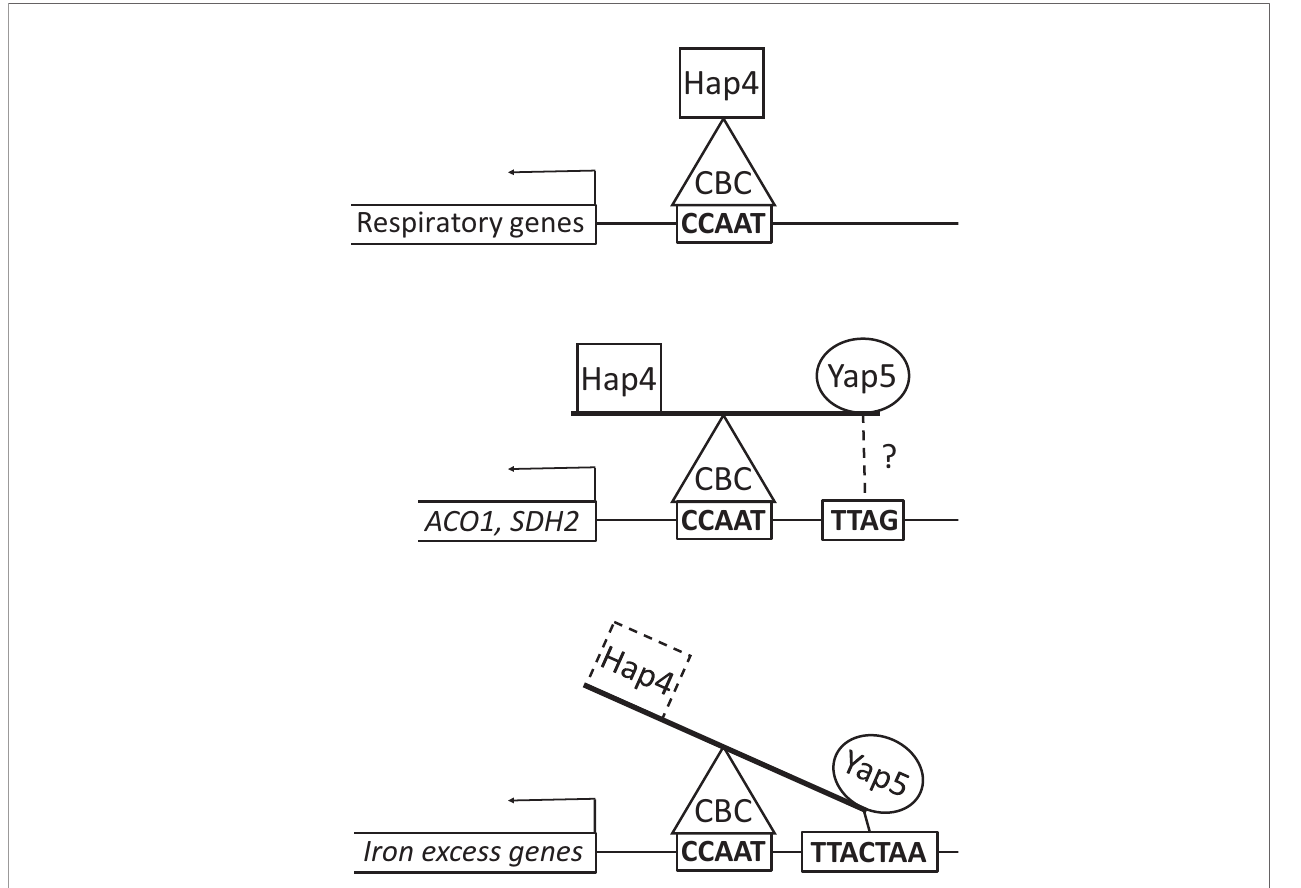
FIGURE 6 | The Hap4/Yap5 balance at the promoters of CBC targets. Hap4 is found at the promoters of all CBC targets, probably because of the strong af fi nity of its perfect Hap4L motif for Hap5. However, at the promoter of iron excess genes (lower panel), the preferred regulatory partner of CBC is Yap5, probably because of the presence of a YRE close to the CCAAT box, which strengthens the CBC-Yap5-DNA interaction. For ACO1 and SDH2 (middle panel), the CCAAT surroundings are less favorable to Yap5 and then the competition with Hap4 is more balanced. Additionally, for ACO1 , a second Hap4 ChIP peak is detected on a CCAAT rich region upstream of the Yap5 peak (not shown on this fi